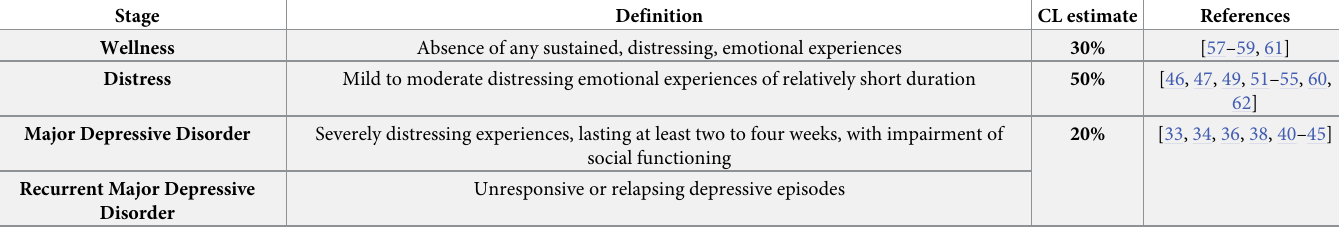
Table 4. Estimating the psychological impact of CL using the staged model of depression adapted from Patel (2017) [19].